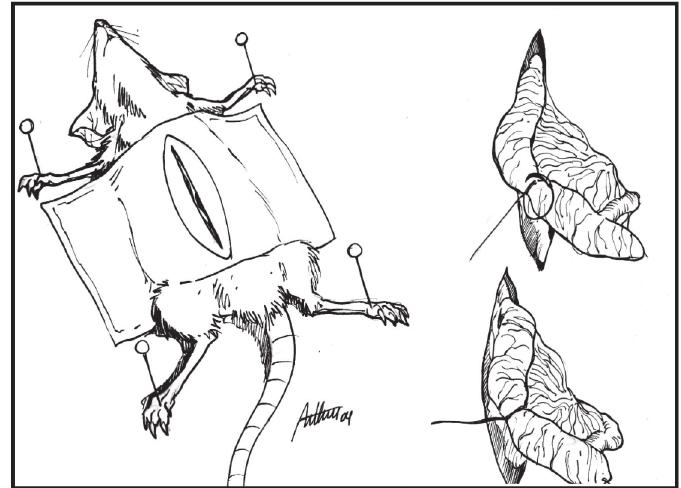
FIGURA 1 – Técnica da indução da peritonite secundária em